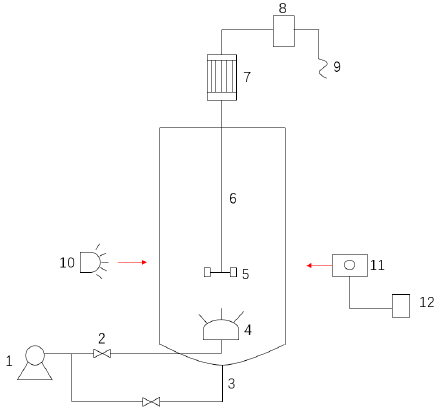
Figure 3. Schematic diagram of experimental device. 1 turbulence pump; 2 air pipe; 3 drain valve; 4 gas distributor; 5 stirring blade; 6 shaft; 7 electromotor; 8 frequency changer; 9 power supply; 10 light source;11 digital camera; 12 computer.